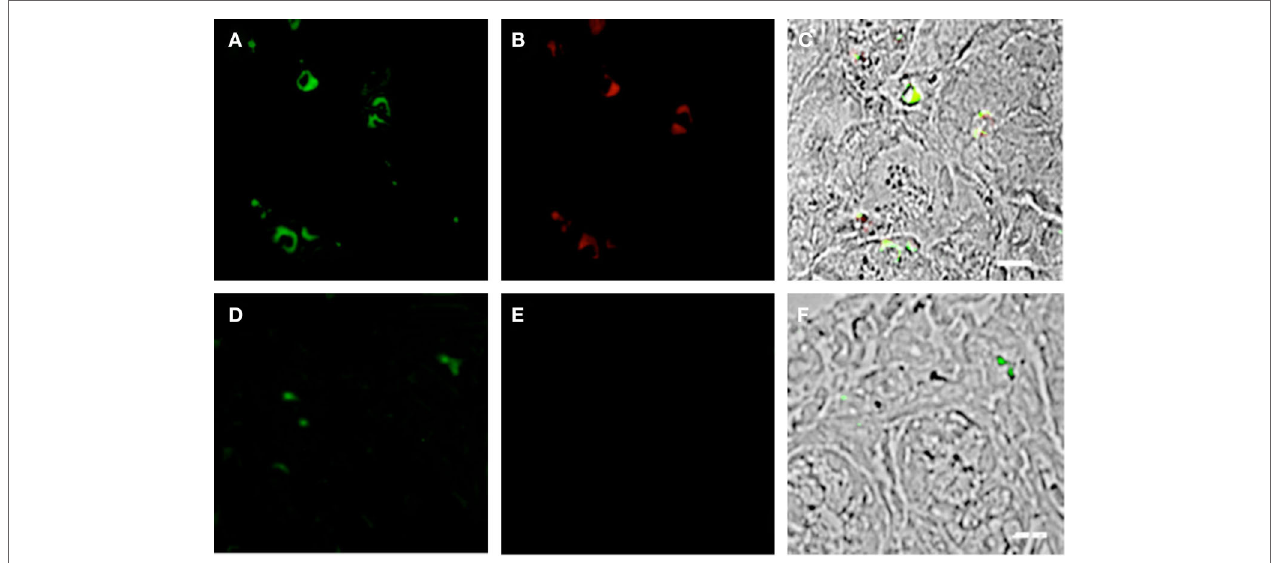
FigUre 8 | Duodenum biopsies of hiV/aiDs cases and controls evaluated for coexpression of cD303 (green) and cD56 (red) . Bar represents 20 μ m. (a) HIV case duodenum biopsies probed with a monoclonal FITC-anti-CD303 antibody. (B) HIV case duodenum biopsies probed with monoclonal APC-anti-CD56 antibody. (c) HIV case duodenum biopsies DIC image merged with (a,B) . (D) Control duodenum biopsies probed with monoclonal FITC-anti-CD303 antibody. (e) Control duodenum biopsies probed with monoclonal APC-anti-CD56 antibody. (F) Control duodenum biopsies DIC image merged with (D,e)